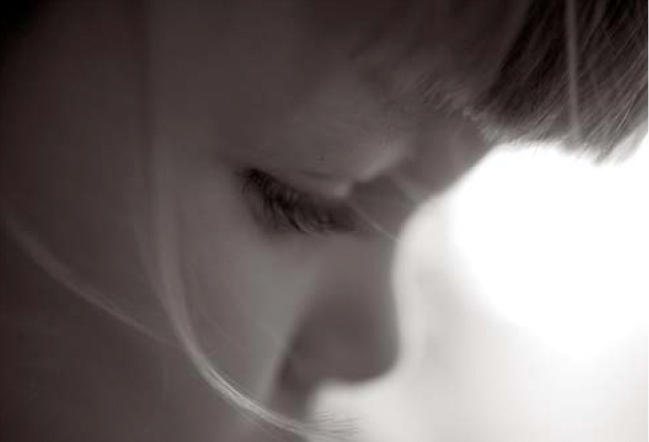
Thought leaderPrenatal exposure to PAHs may affect cognitive development later on.